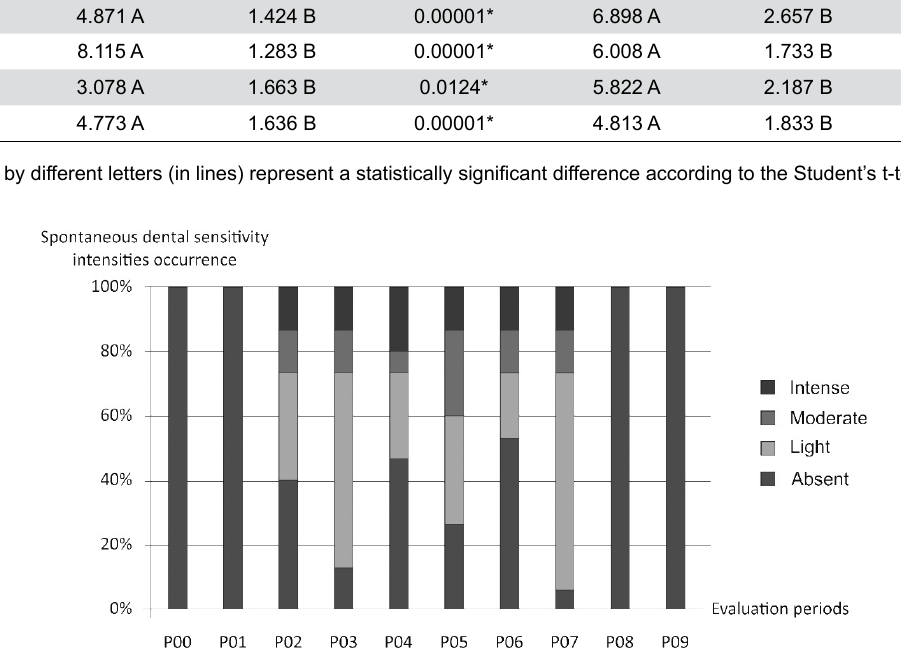
Figure 8- Different means of spontaneous dental sensitivity intensities obtained using Visual Analogue Scale (VAS) in the different periods of study (Group I - Low